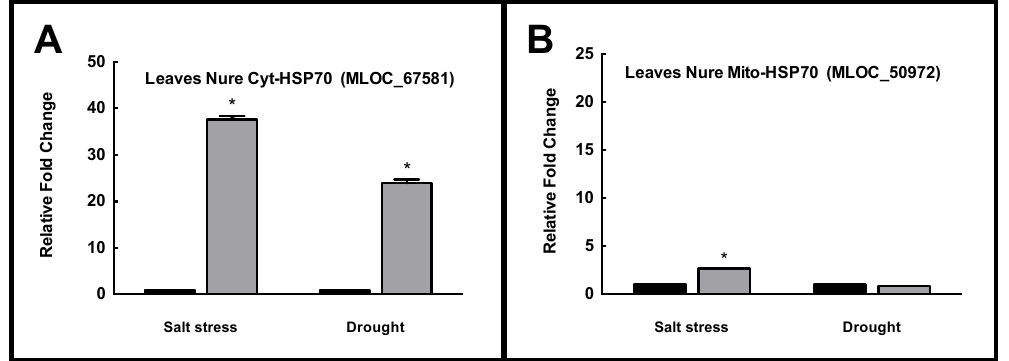
Figure 4. ( A ) The changes in the expression of Cyt-HSP70 (MLOC_67581) (abiotic stress responsive); and ( B ) Mito-HSP70 (MLOC_50972) (biotic stress responsive) in leaves of barley plants cv. Nure collected after 3 days of exposure to salt stress (NaCl 150 mM) and drought (PEG 10%). Asterisks (*) indicate p value ≤ 0.001.